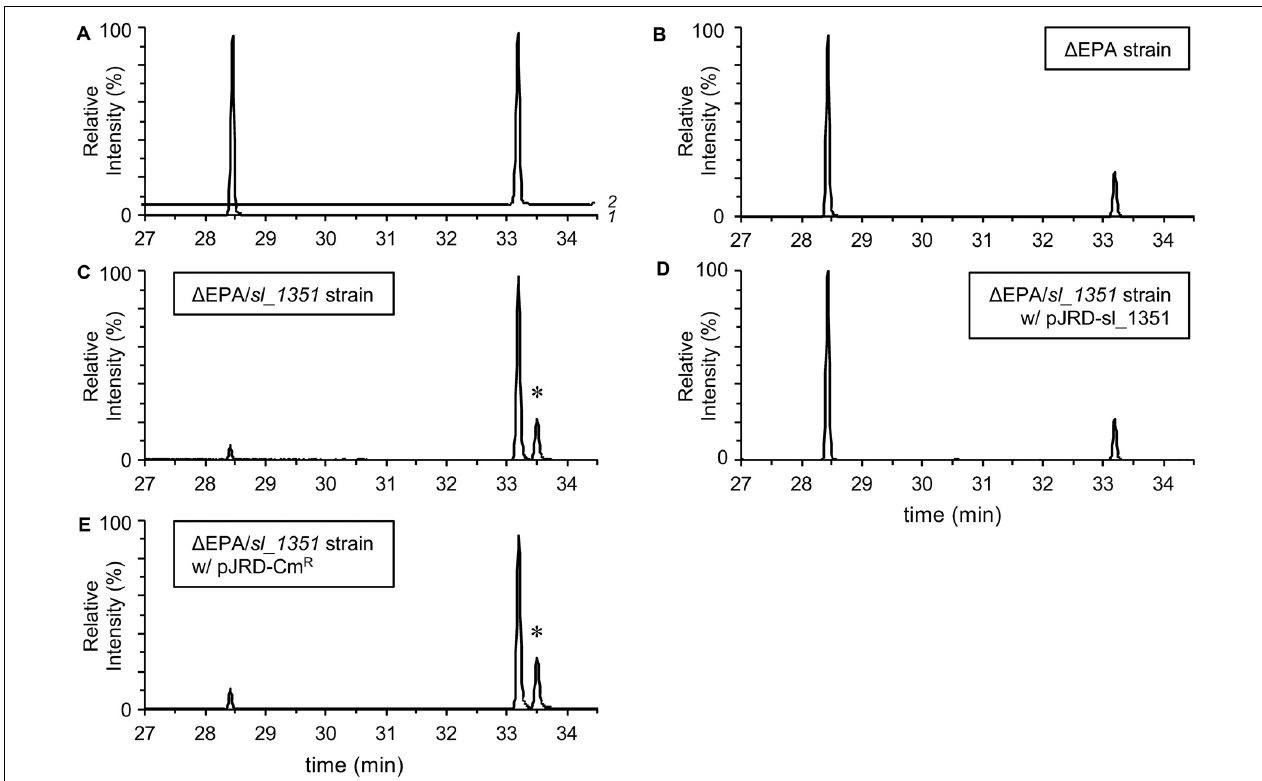
FIGURE 2 | GC/MS analyses of fatty acid compositions. Authentic EPA and DHA methyl esters ( A ; traces 1 and 2, respectively) and the FAMEs of the (cid:49) EPA strain (B) , (cid:49) EPA/ sl_1351 strain (C) , (cid:49) EPA/ sl_1351 strain harboring pJRD-sl_1351 (D) , and (cid:49) EPA/ sl_1351 strain harboring pJRD-Cm r (E) grown in the presence of DHA were analyzed. An asterisk indicates the peak putatively representing methyl docosaheptaenoate.